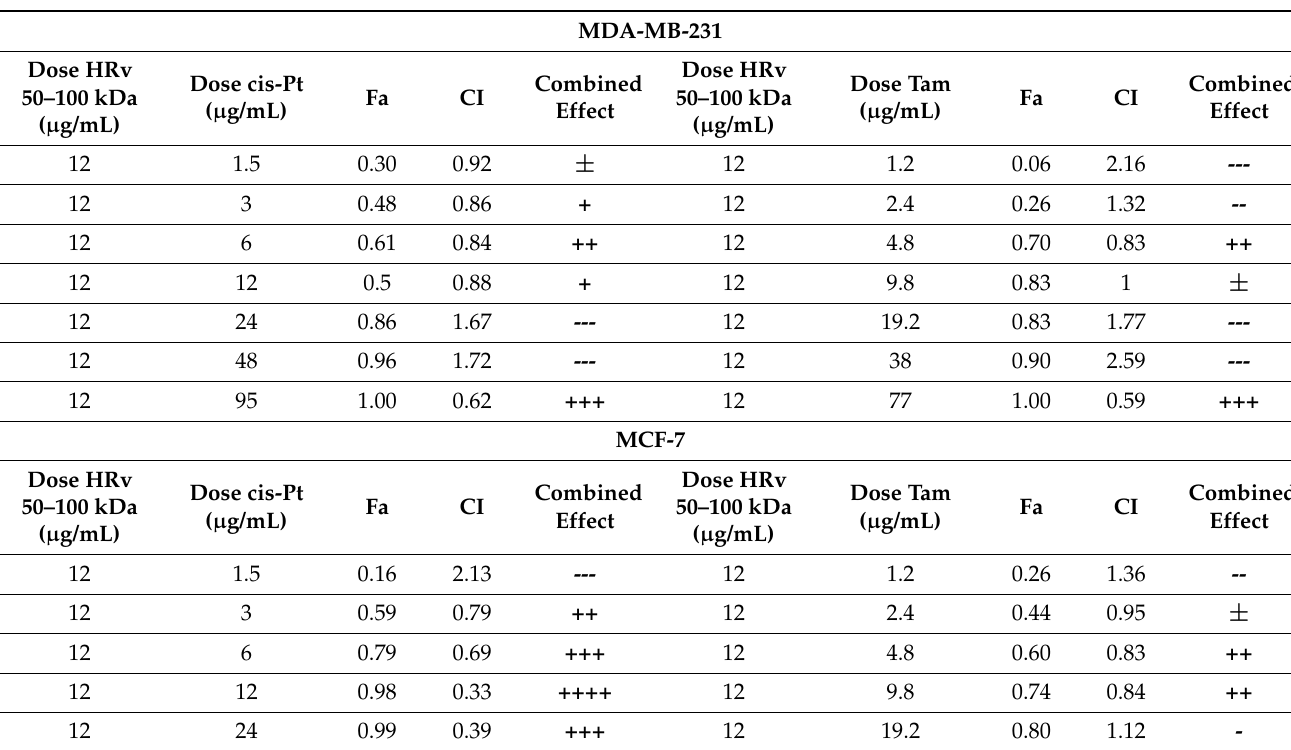
Table 3. IC 25 of BAS, isolated from R. venosa , in combinations with cisplatin or tamoxifen in serial dilutions from 16 to 512 μ M tested on breast cancer cell lines MCF-7 and MDA-MB-231 and the non- cancerous MCF-10A breast cell line.